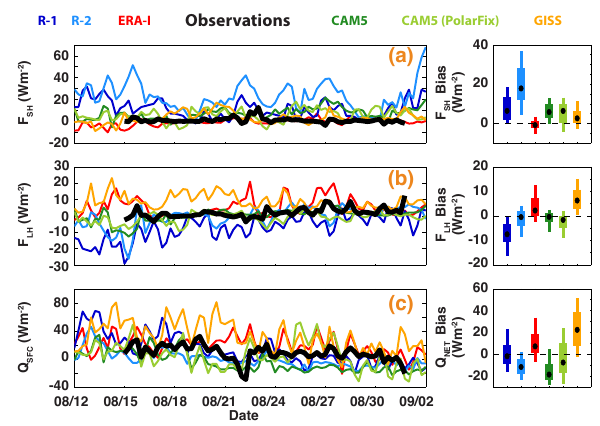
Fig. 6. Time series of surface energy budget terms from top to bot- tom: average sensible heat flux density, average latent heat flux den- sity, and net surface energy (radiation, latent heat and sensible heat). Included are lines for the observations from Oden (bold black line), CAM5 (standard version, dark green; CAM5-PF, light green), the GISS-ModelE2 (orange), and R-1 (dark blue), R-2 (light blue) and ERA-I (red) reanalyses. All lines represent six-hour average values. The right-hand side of the figure includes distributions depicting the median (black dot), IQR (wide bar) and 10th–90th percentiles (thin bar) of the differences between simulated and observed